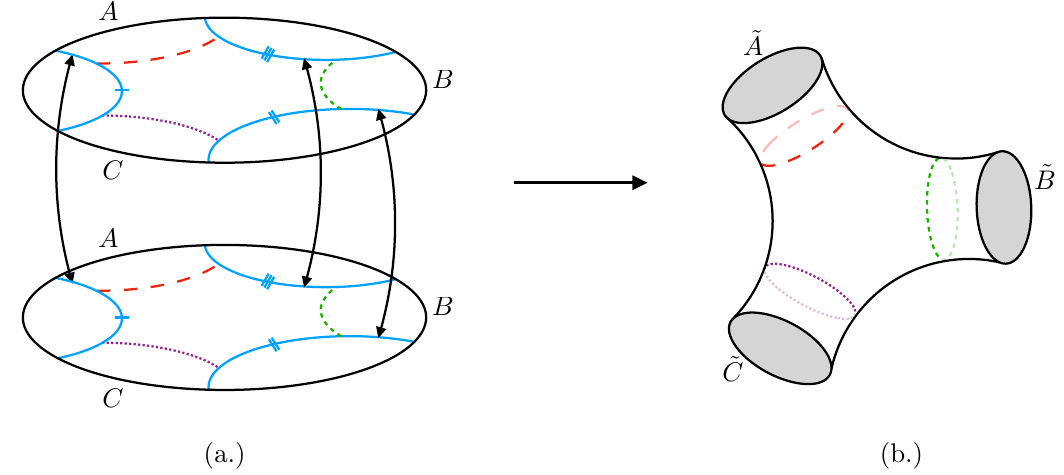
Figure 8 . The doubling procedure for generating a multiboundary wormhole, illustrated here for k = 3 boundary subregions. (a) A single Poincar(cid:19)e disk containing the original subregions is (cid:12)rst doubled. Identifying boundary-anchored geodesics (blue lines) between the original and the double produces a 3-sided wormhole (b). The horizons in the wormhole throats (dashed lines) correspond to geodesic segments in the original pre-quotient